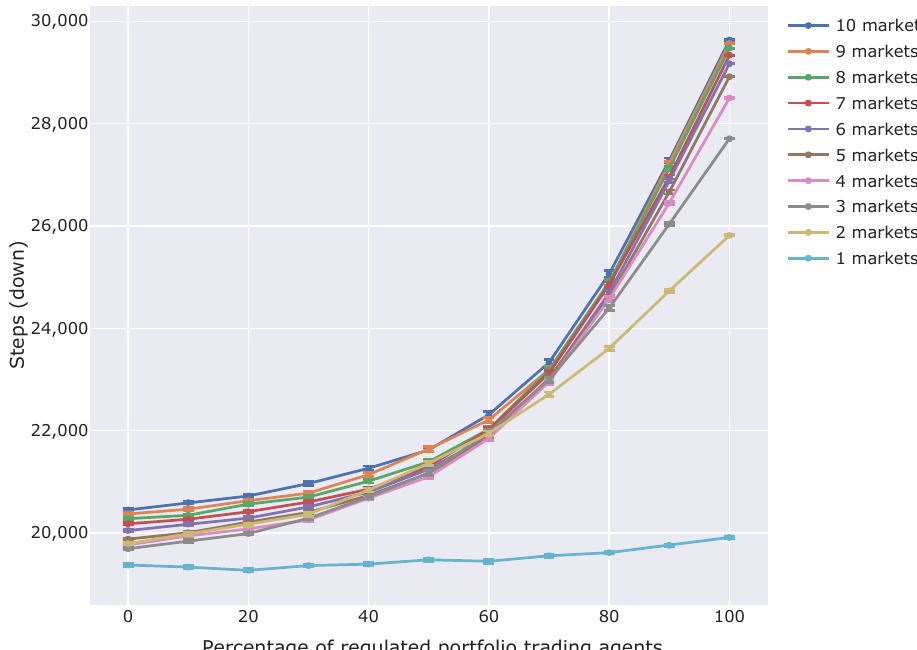
Figure 12. Steps in which the market prices went down. The horizontal axis is the percentage of regulated portfolio trading agents among all non-regulated and regulated portfolio trading agents. The vertical axis is the mean number of Steps in which the market prices went down. Each series of plots shows results for a certain number of markets in the simulation. Error bars show standard